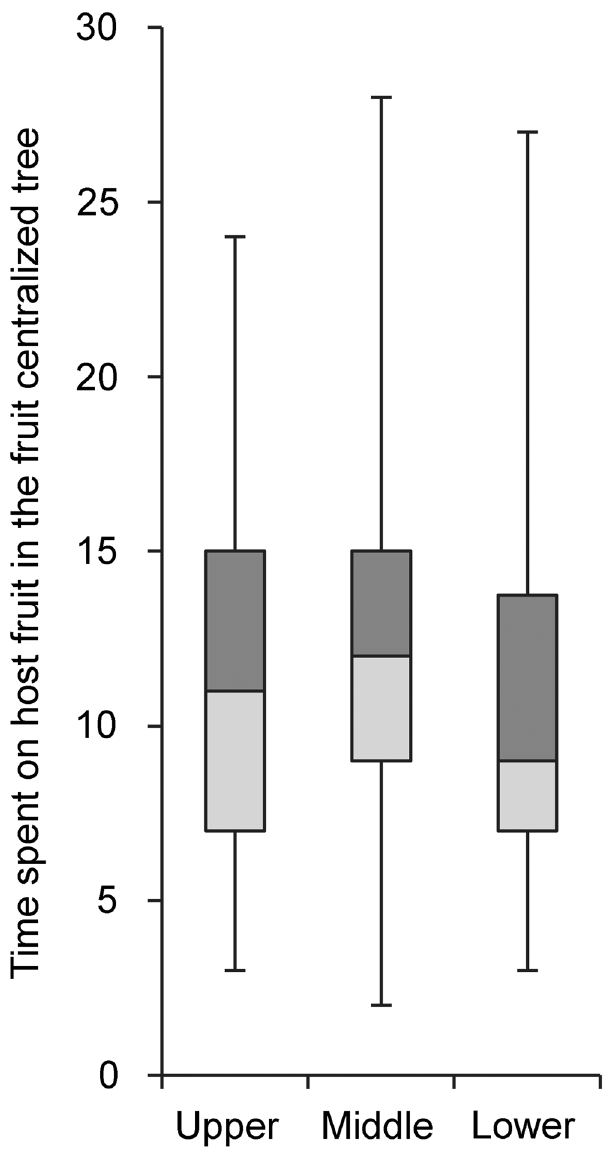
Fig 7. The results of fruit-centralized tree treatment. Median time (min) spent by 30 Bactrocera tryoni on host fruit in each part of the fruit-centralized tree (Kruskal-Wallis test: Median = 11|12|9, H = 5.43, df = 2, P = 0.066, n = 50